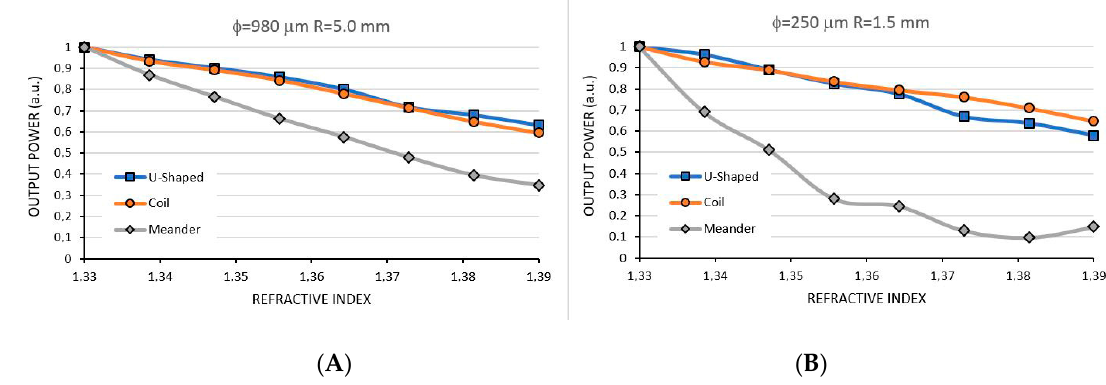
Figure 12. Comparing the simulated sensitivity between U-Shaped, Coil- and Meander-shaped with φ = 980 µm, R = 5.0 mm ( A ) and φ = 250 µm, R = 1.5 mm sensor ( B ) for RI sensing.